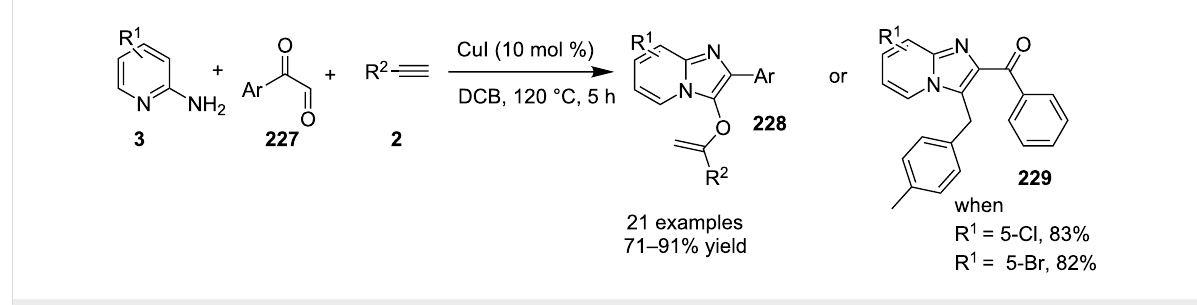
Scheme 77: Copper-catalyzed synthesis of vinyloxy-IP.